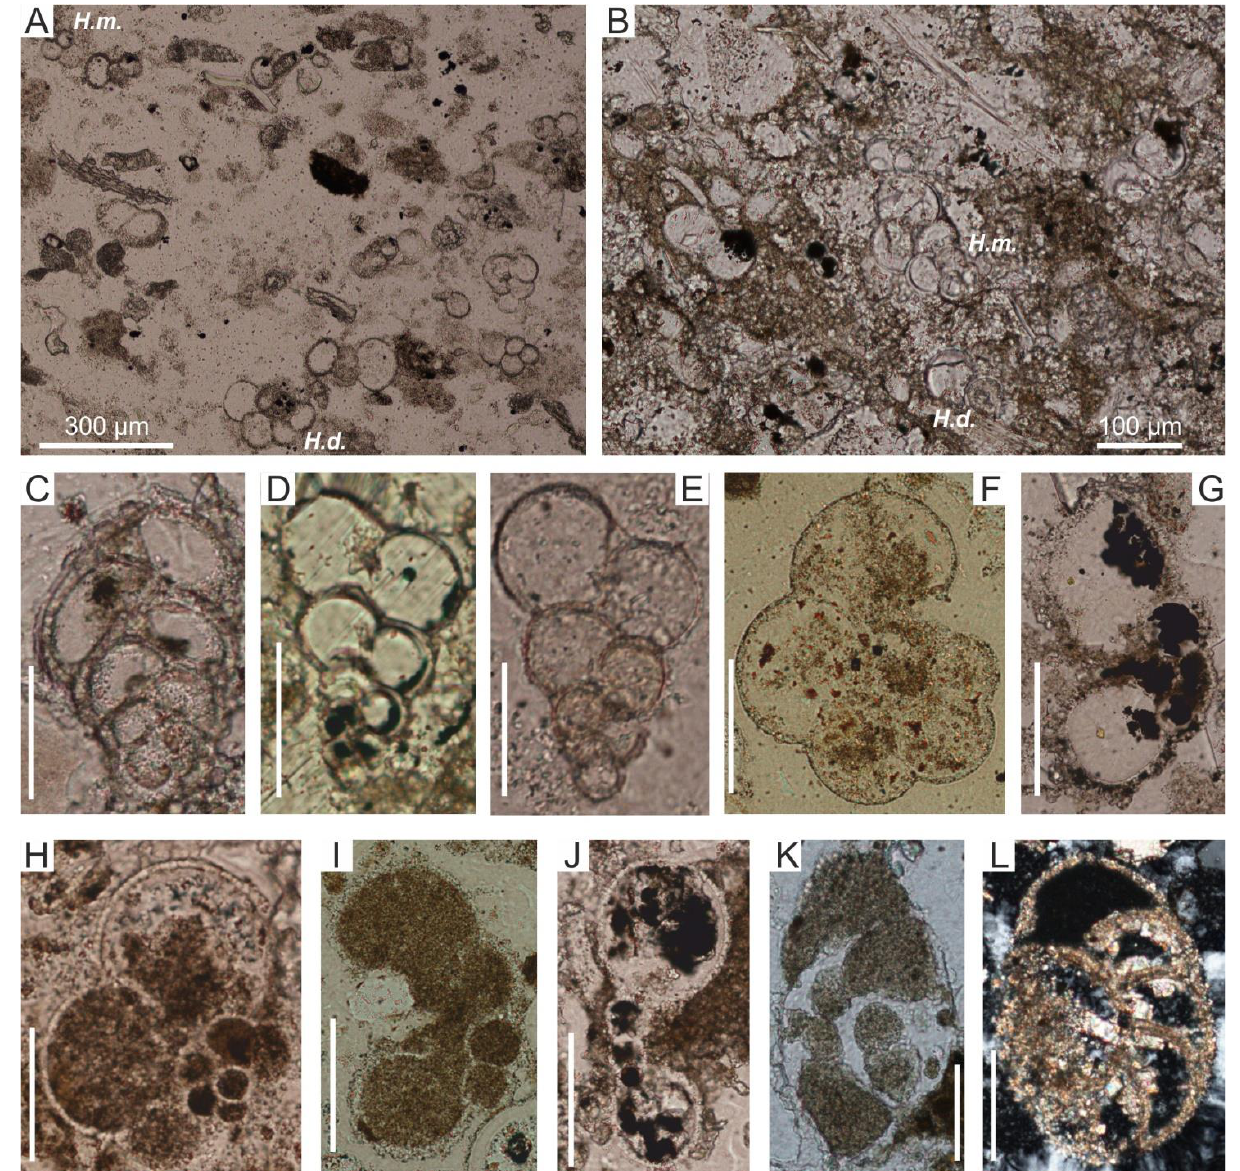
Figure 9. ( A , B ) Foraminiferal biomicrite dominated by trochospiral forms from the genus Hedbergella (H.d.) and biserial forms from genus Planoheterohelix (P.m); ( A ) — sample 2998, subsection E; ( B ) — sample 3115, subsection C. Redeposited planktonic foraminifera from biomicrites of turbidite layers in the Mikuszowice Chert Beds. ( C – E ) Planoheterohelix moremani (Cushman), ( C ) — sample J3105, ( D , E ) — sample 2996. ( F – J ) Hedbergella spp., ( F ) — sample J3205, ( G ) — sample J3001, ( H